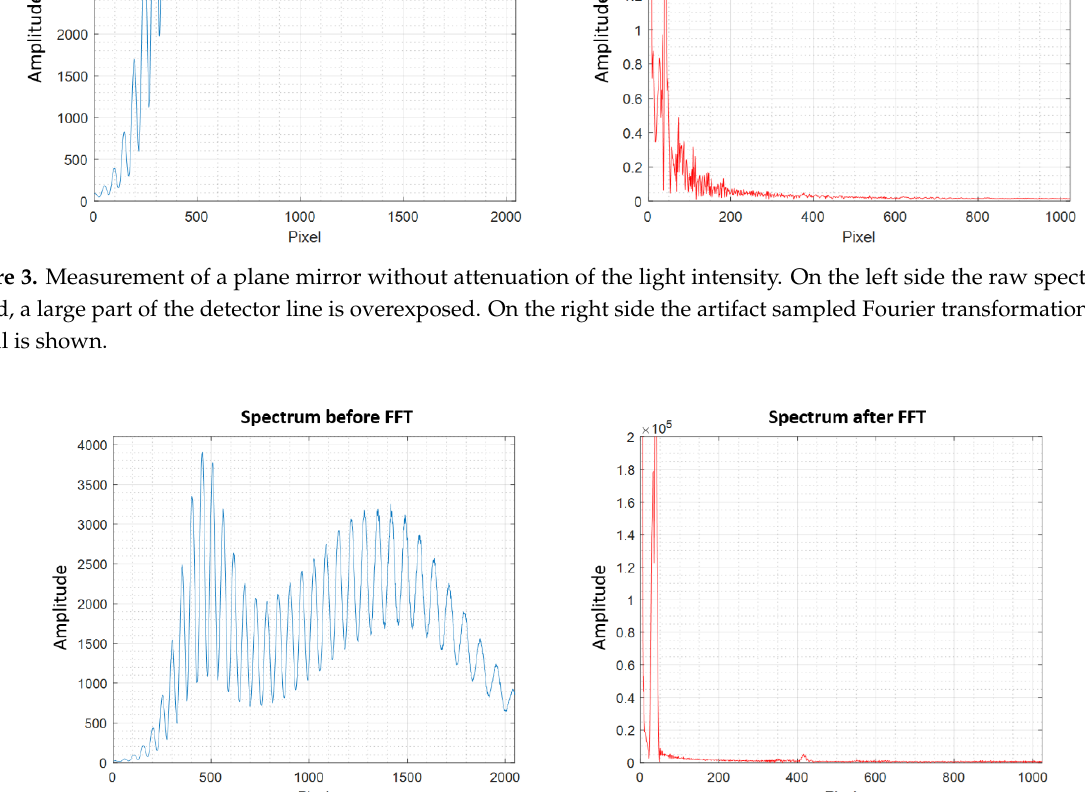
Figure 3. Measurement of a plane mirror without attenuation of the light intensity. On the left side the raw spectrum is found, a large part of the detector line is overexposed. On the right side the artifact sampled Fourier transformation of the signal is shown.